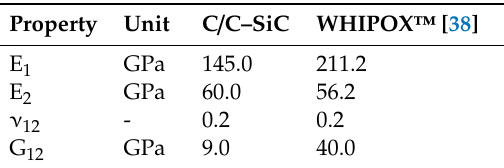
Table 3. Elastic properties of the virtual unidirectional layer used for the evaluation of the elastic properties of laminates with varying fiber